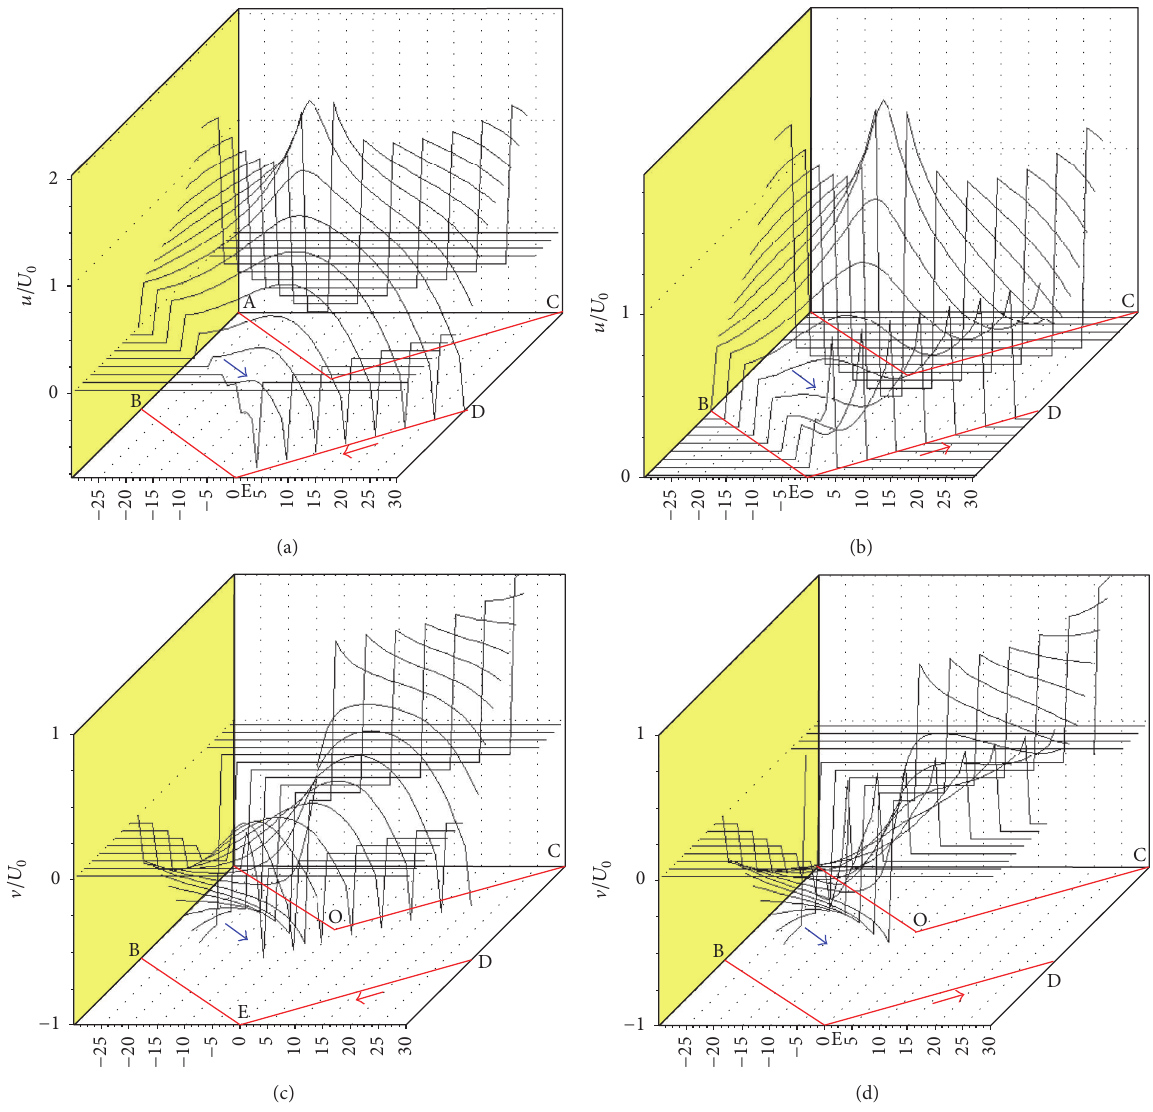
Figure 11: CFD-derived diagrams for the dimensionless 𝑥 -projection 𝑢 of the flow velocity 𝑤 (a, b) and for the dimensionless 𝑦 -projection V of the flow velocity 𝑤 (c, d) for a Segal die with channel intersection angles ∠ (AOC) = 2 𝜃 = 105 ∘ , where outlet die wall ED moves upstream towards the punching direction with velocity 𝑉 𝑤 = −𝑈 0 (a, c), outlet die wall ED moves downstream stream-wise with velocity 𝑉 𝑤 = +𝑈 0 (b, d), 𝑈 0 is punching velocity, and the dimensional transition times are 1172ms = 1.172 s (a, c) and 1831ms = 1.831 s (b,